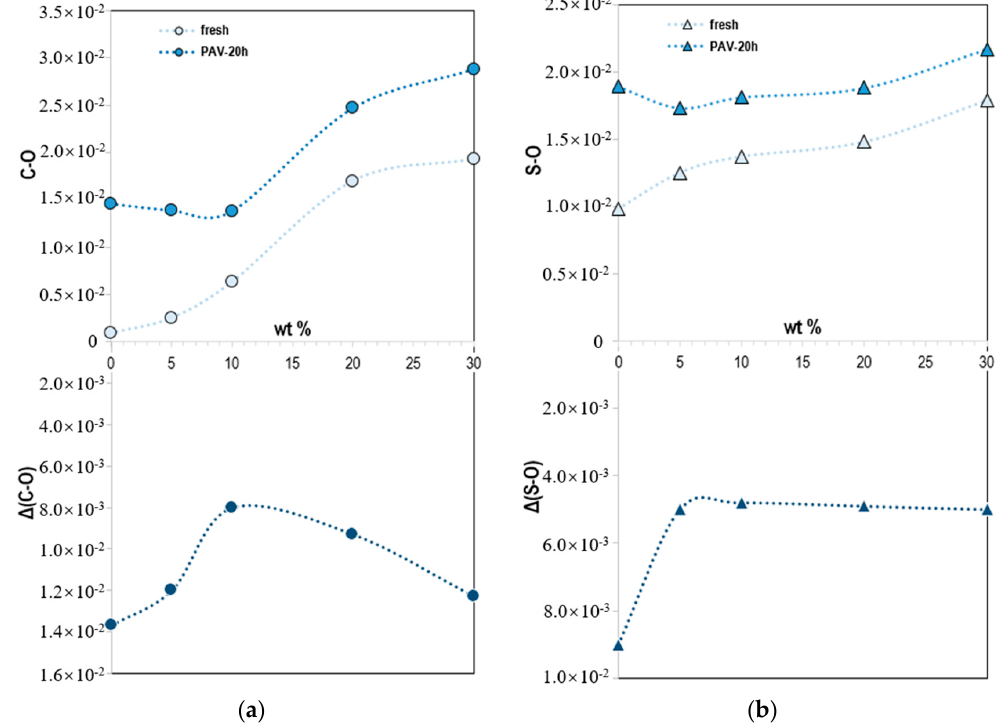
Figure 3. The ( a ) carbonyl (1700 cm − 1 ) and ( b ) sulfoxide (1030 cm − 1 ) indices of lignin–bitumen systems and their incremental values before and after pressure-aging vessel (PAV) aging.